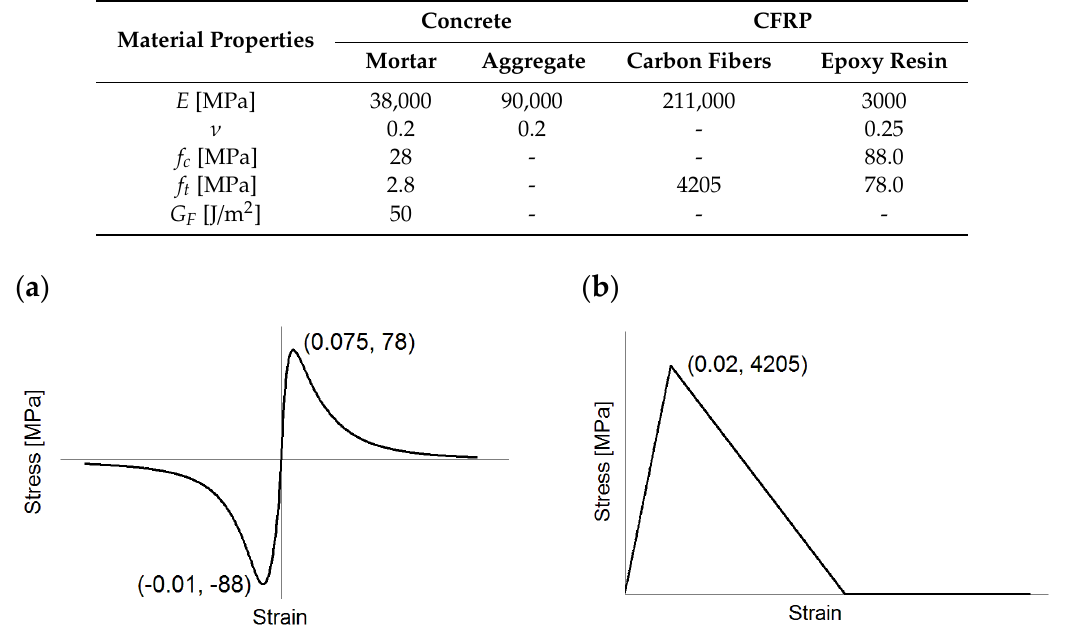
Table 1. Mechanical properties of concrete and Carbon Fibre Reinforced Polymer (CFRP).